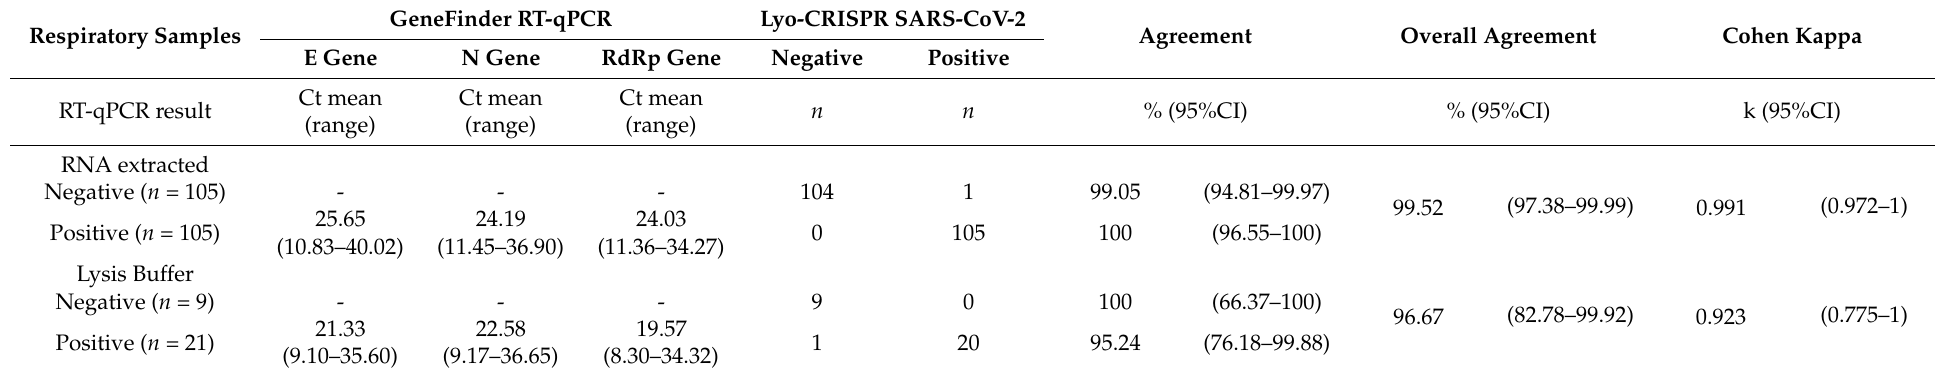
Table 1. Agreement between GeneFinder RT-qPCR and Lyo-CRISPR SARS-CoV-2 kit results for testing samples extracted with spin column ( n = 210) and samples in lysis buffer ( n = 30) from hospitalized